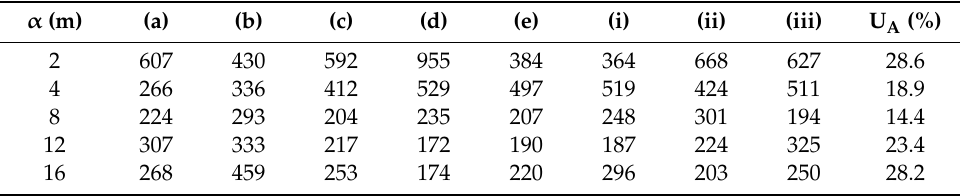
Table 1. Apparent soil resistivity measurements ( Ω .m) at the eight measurement